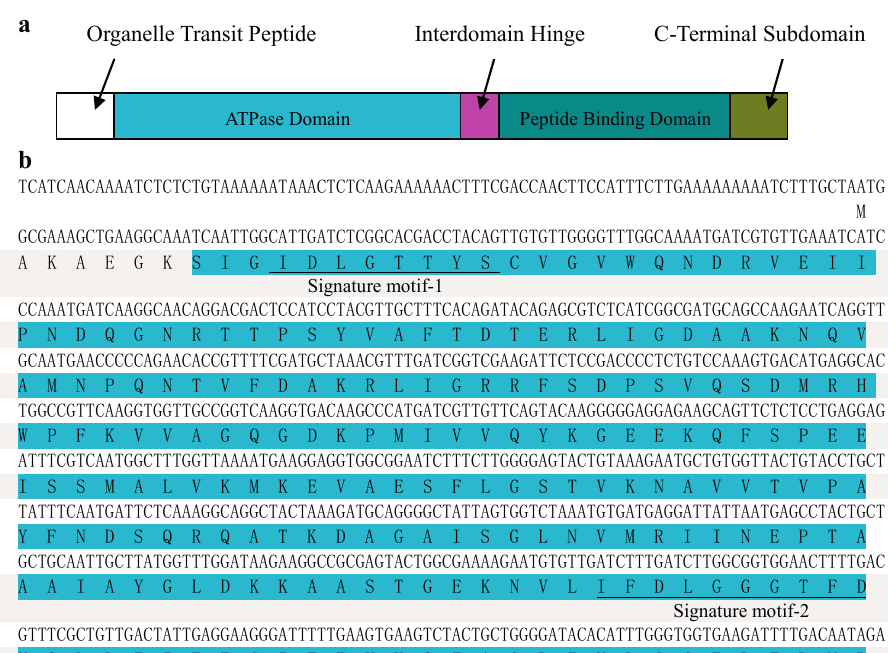
Figure 1. Nucleotide sequence and deduced amino acid sequence of CaHsp70-1 . ( a ) Schematic representation of CaHsp70-1 protein structure; ( b ) The nucleotide sequence and amino acid sequence of CaHsp70-1. A putative open reading frame (ORF) started with ATG and ended with TAA. An asterisk below the last three nucleotides indicates a stop codon; Hsp70 signature motifs and cytosolic Hsp70 -specific motif are underlined. The sequence is color coded to match the diagram in ( a